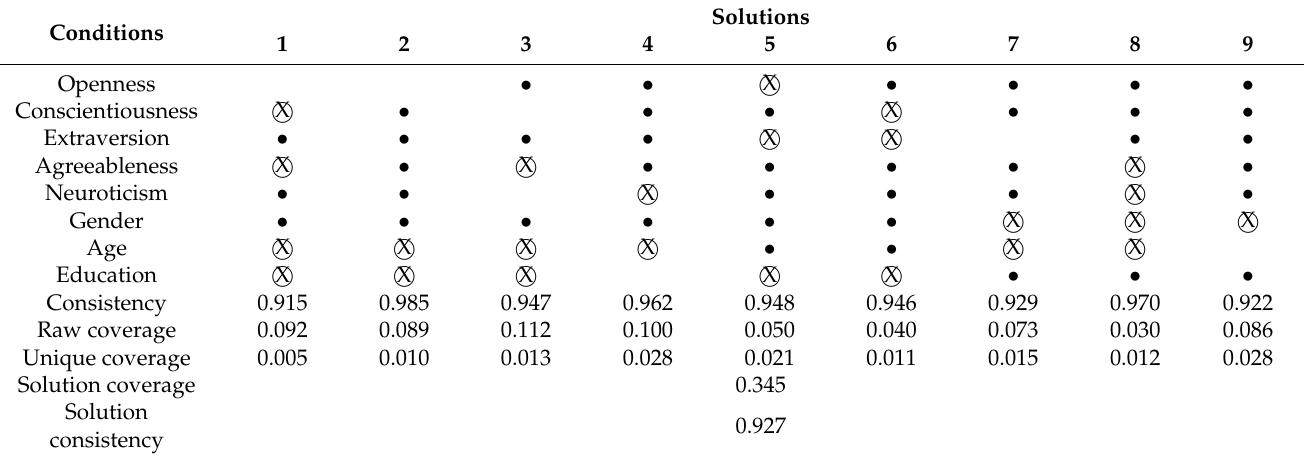
Table 7. Analysis of sufficient conditions (sociodemographic variables and personality